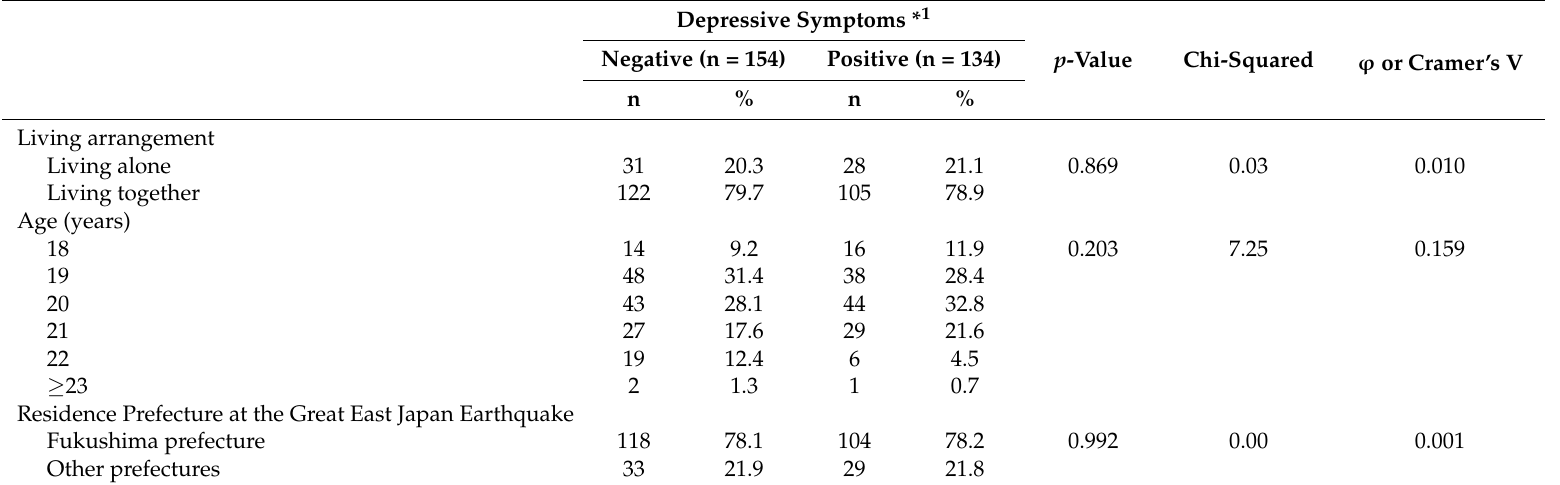
Table 1. Participants’ sociodemographic characteristics.